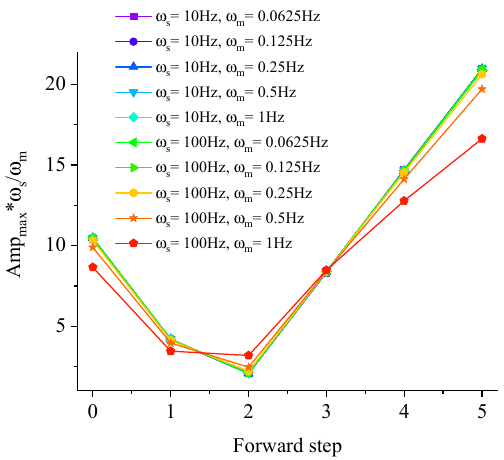
Figure 11. Amplitudes of payload motion with different numbers of steps.